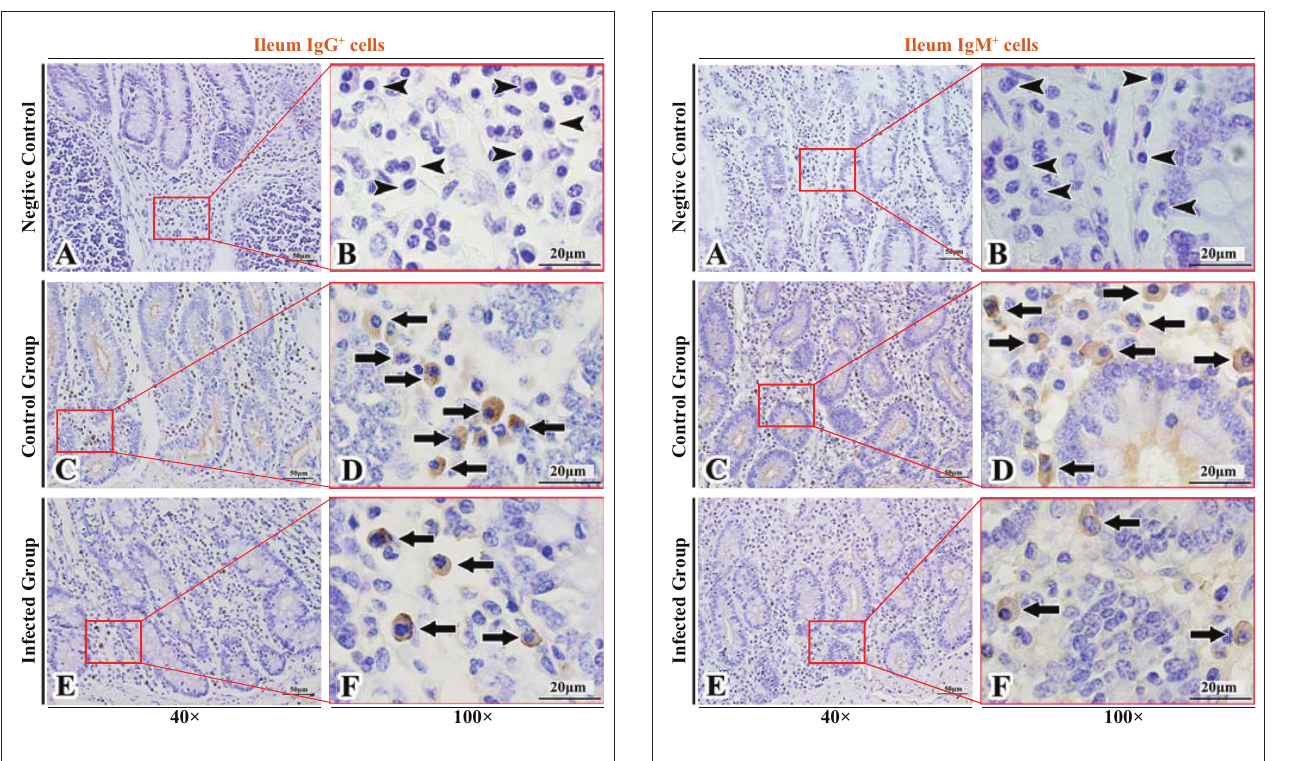
decreased by 44.84%, 90.53%, and 34.23%, respectively; IgG + cells were decreased by 66.44%, 80.61%, and 82.64%, respectively; and IgM + cells were reduced by 42.92%, 65.02%, and 84.07%, respectively ( Table 1